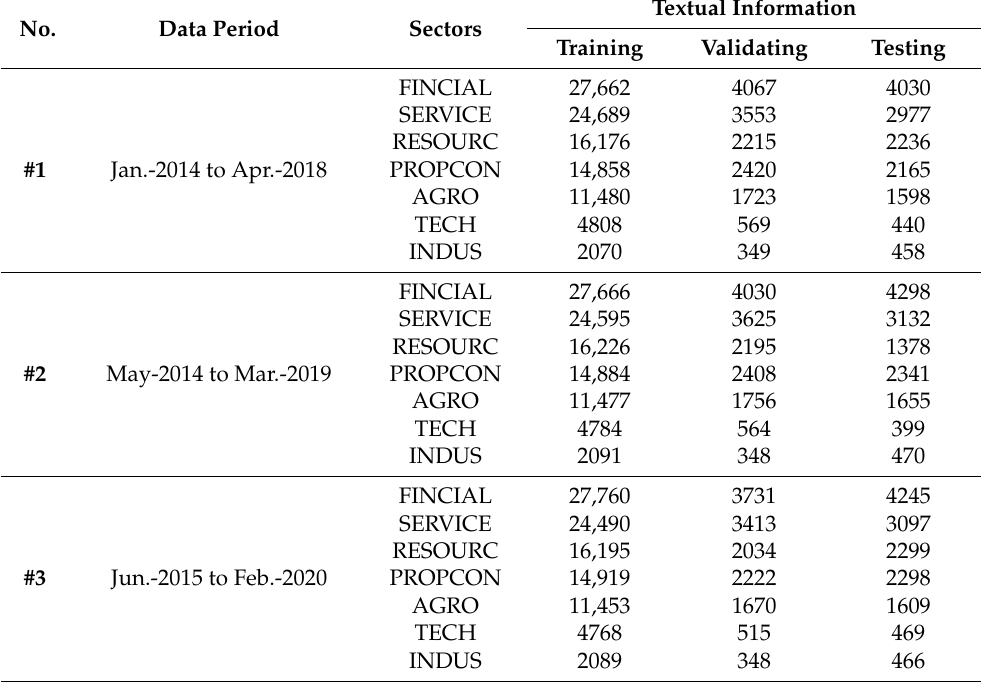
Table 6. Data statistic for industry grouping